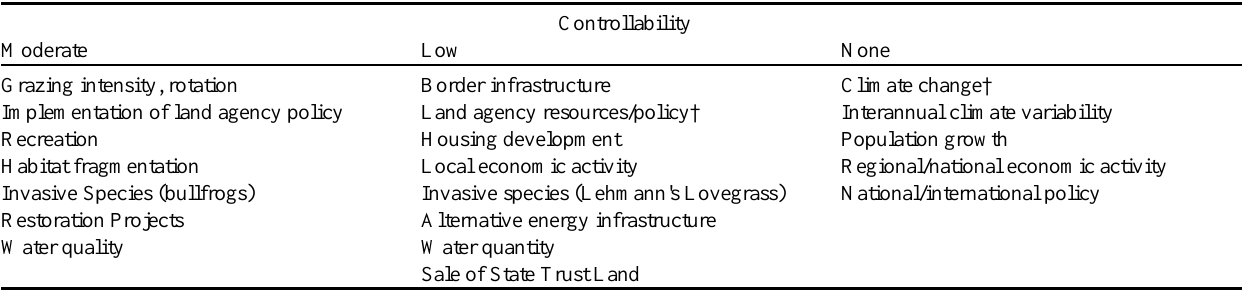
Table 1 . Numerous changes observed in the Sonoita Valley are categorized by the amount of control local managers and stakeholders have over these changes. As control of their causes and consequences decreases, nested management objectives and scenario planning become increasingly important. Changes marked with † represent changes that stakeholders have indicated should be considered components of any scenario planning